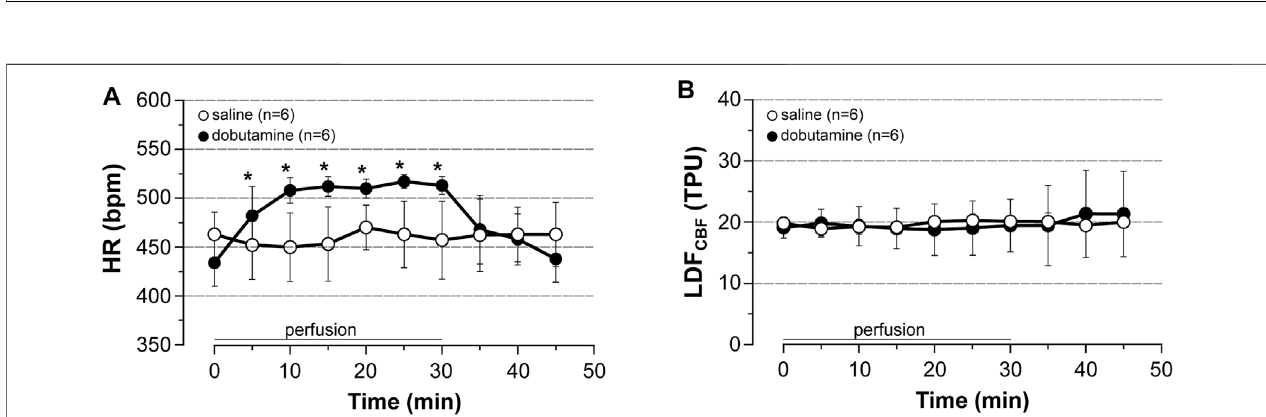
FIGURE6| Cardiovasculareffectsofdobutamine.Dobutamine(10 μ g/kg/min,5.5 μ l/min/100 gfor30 min, i.v)orsalinewasperfusedtounstimulatedrats. (A) HR was calculated from BP trace that was recorded from the femoral artery, (B) LDF CBF was measured in the cortical area representing the hindlimb. Values are expressed as means ± SD, n = number of rats. * signi fi cantly different from control values after one-way ANOVA and Bonferroni correction at p < 0.05.